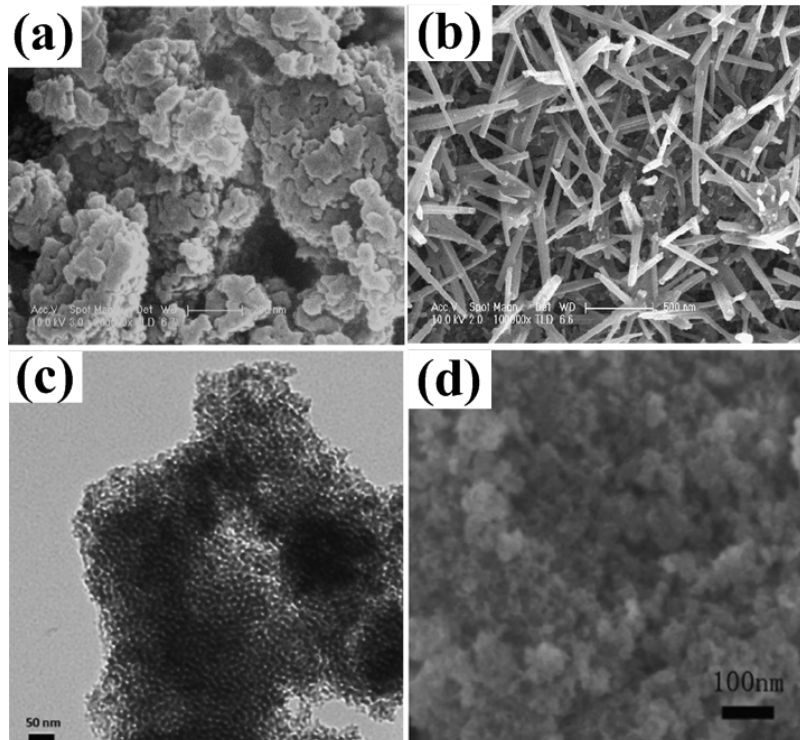
Figure 4. Scanning electron microscopy (SEM) images of MnO 2 samples synthesized by sonochemical method with two different amplitudes: ( a ) 30 μ m; ( b ) 60 μ m